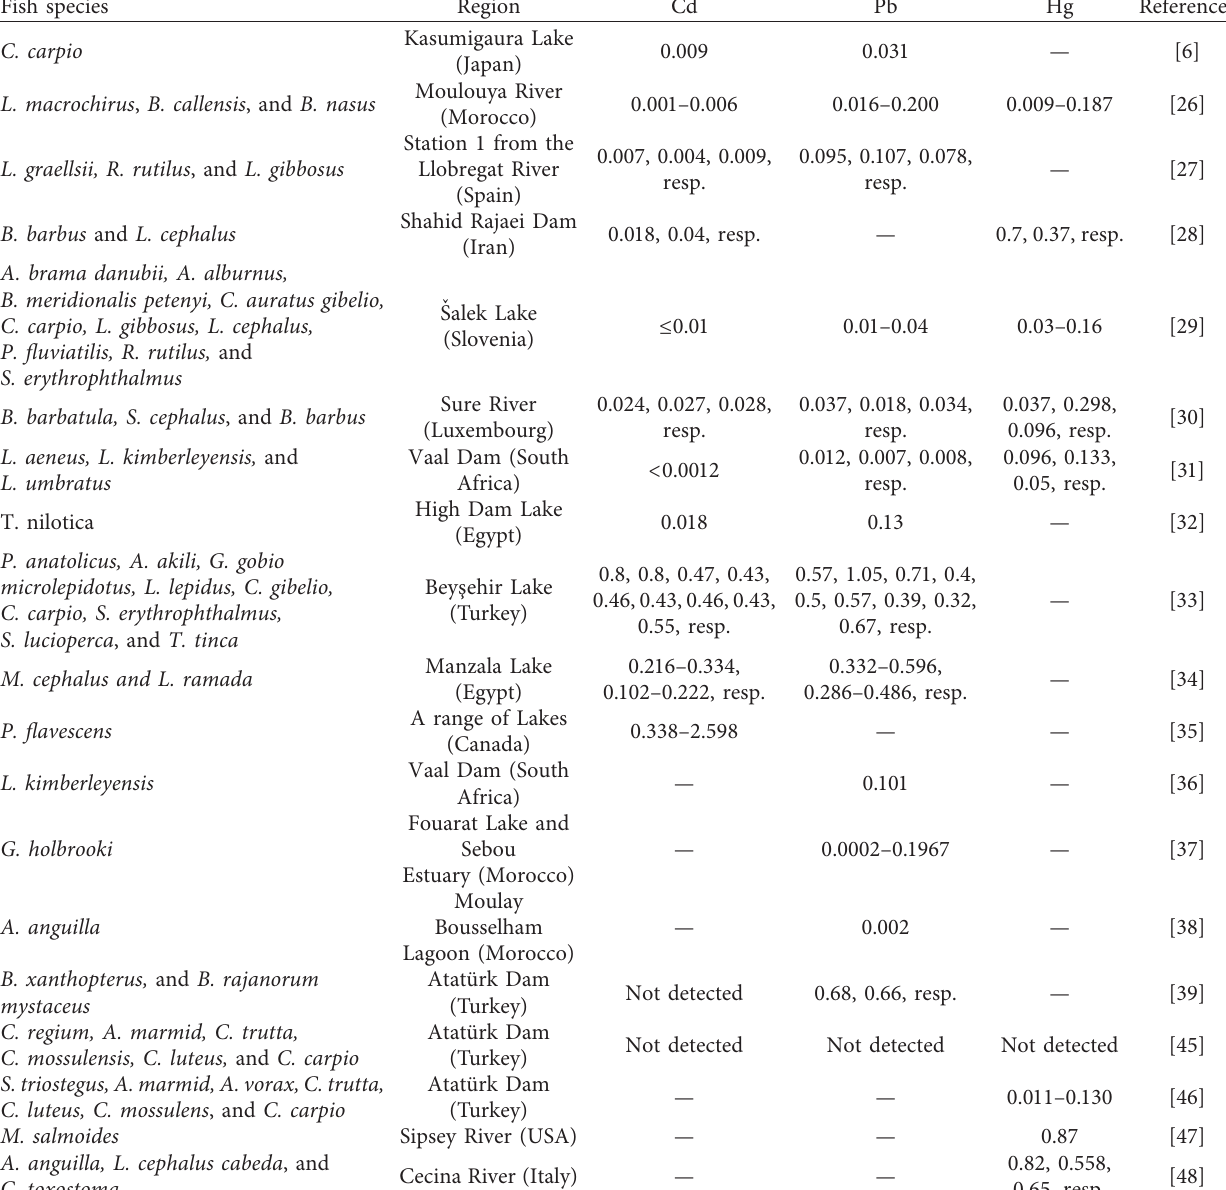
Table 10: Comparisons of recorded trace metal levels in the muscles of the fish species during the present study with the literature reported from different areas (mg/kg of wet